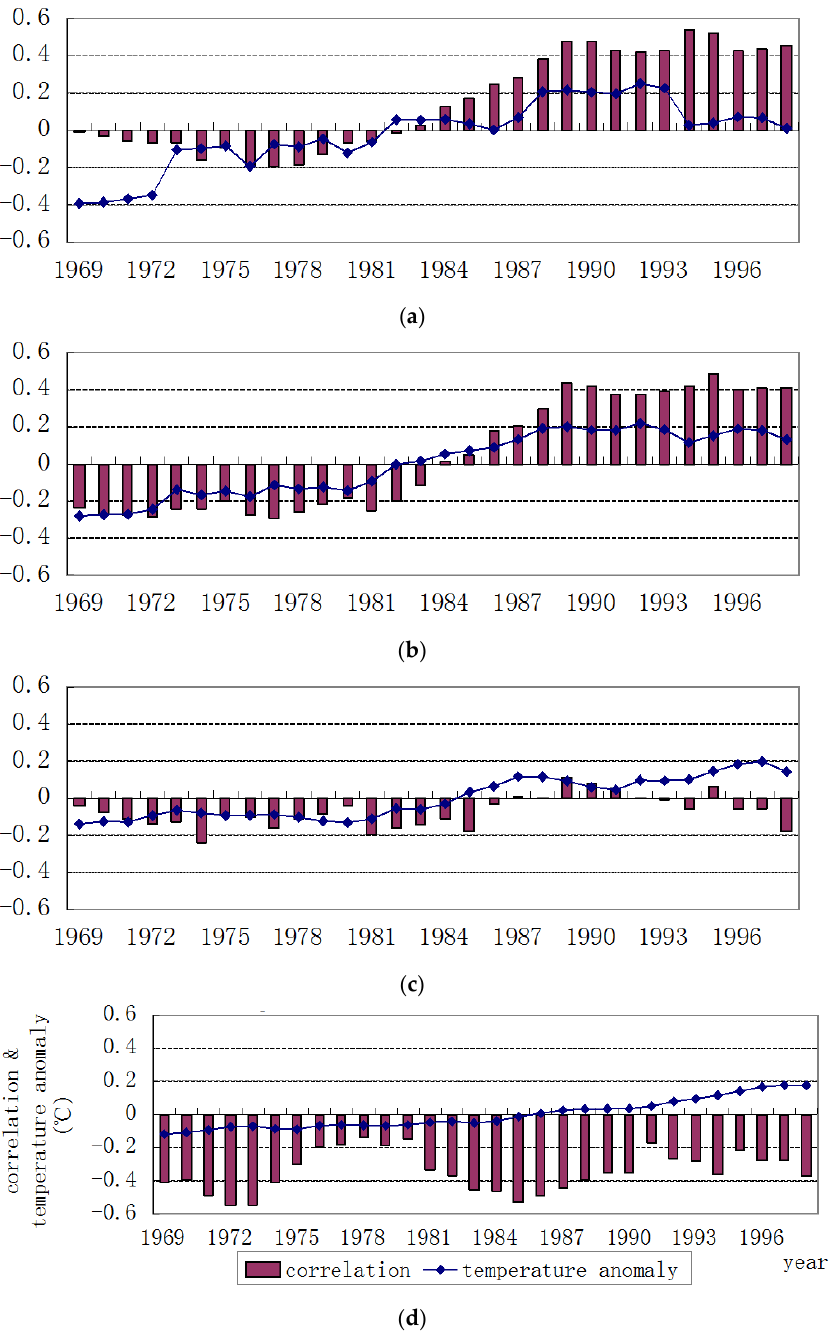
Figure 8. The 21-a moving correlation (histograms) between the rainfall in PFSSC and the equatorial Pacific Ocean temperature in April–June and the 21-a moving average anomaly of the Pacific Ocean temperature (line, unit: °C). The NINO1 + 2 region as ( a ), NINO3 region as ( b ), NINO4 region as ( c ) and the warm pool region as ( d ).